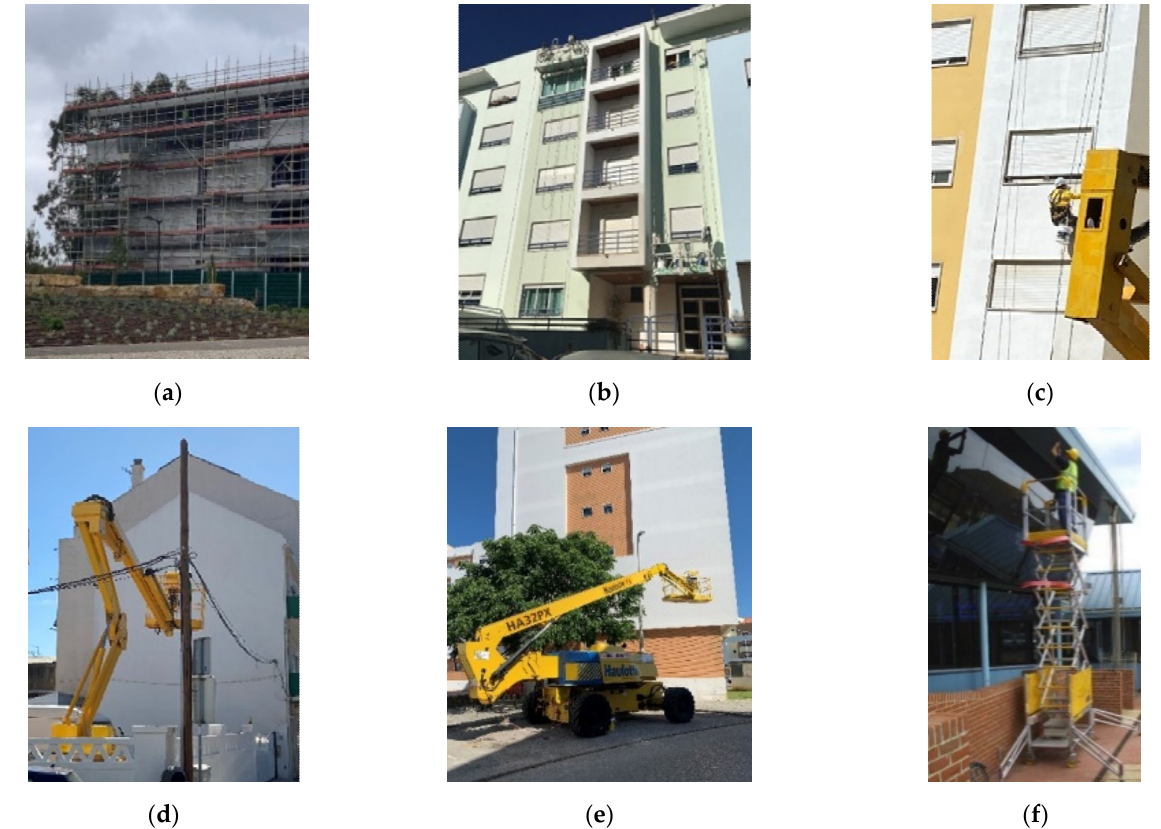
Figure 1. Illustrative examples of the different temporary means of access: ( a ) supported scaffolds; ( b ) suspended scaffolds; ( c ) rope access; ( d ) articulated booms; ( e ) telescopic booms; ( f ) scissor lifts.